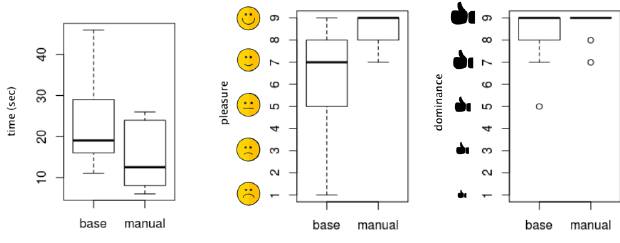
Fig. 6. Boxplots of the time and movements metrics and pleasure and dominance indexes - text box. the user when the component has been